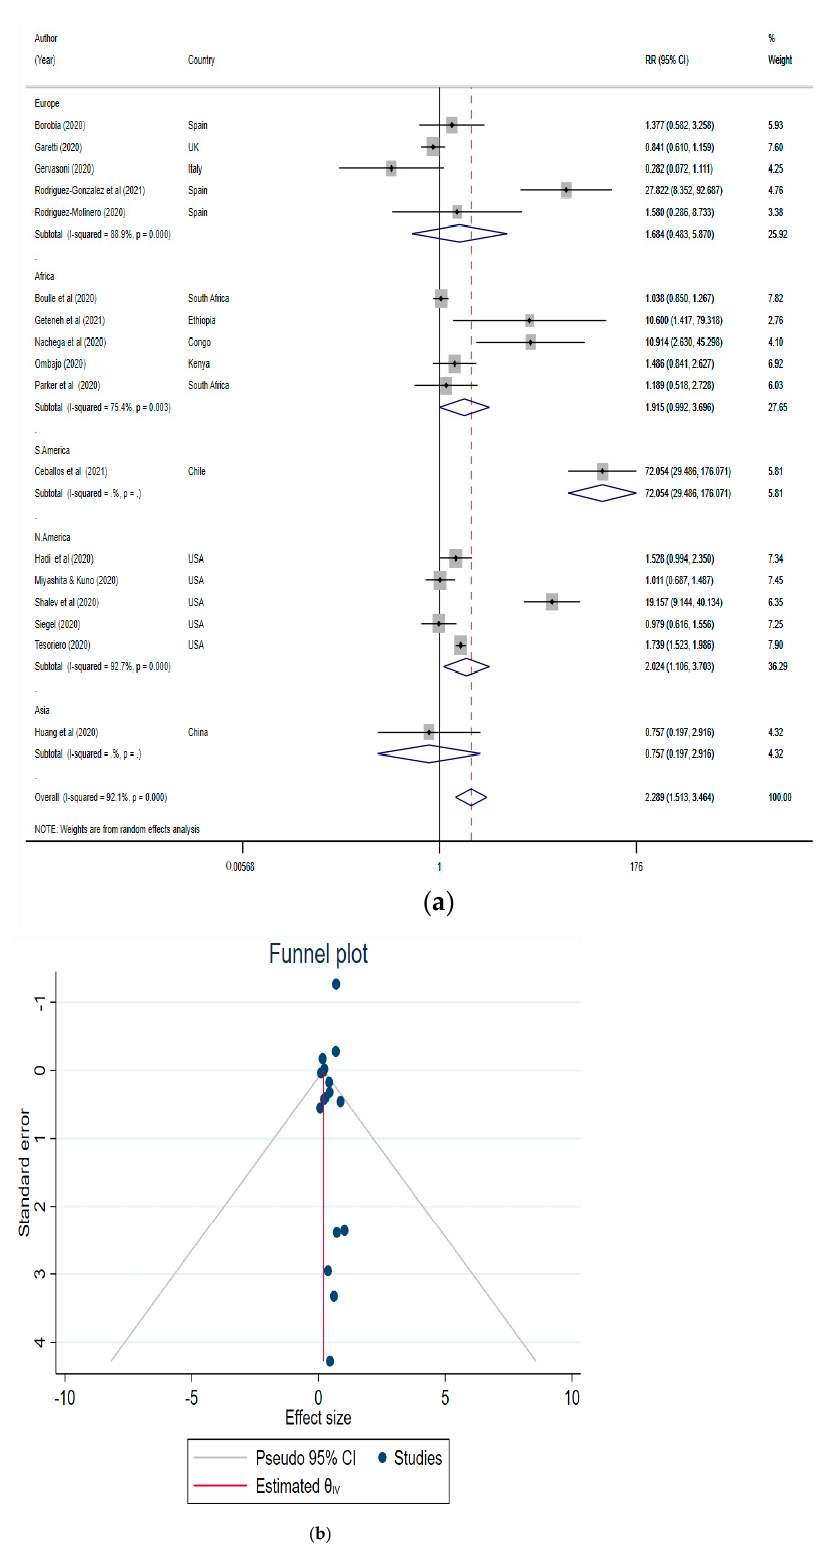
Figure 4. ( a ) Forest plot for COVID-19 mortality in PLWH. The red dotted line represents the overall effect size/risk ratio. The lateral edges of the blue diamonds represent the limits of the 95% confidence intervals(RR: risk ratio; CI: confidence interval) . ( b ) Funnel plot of studies pooled for COVID-19 mortality in PLWH (CI: confidence interval).